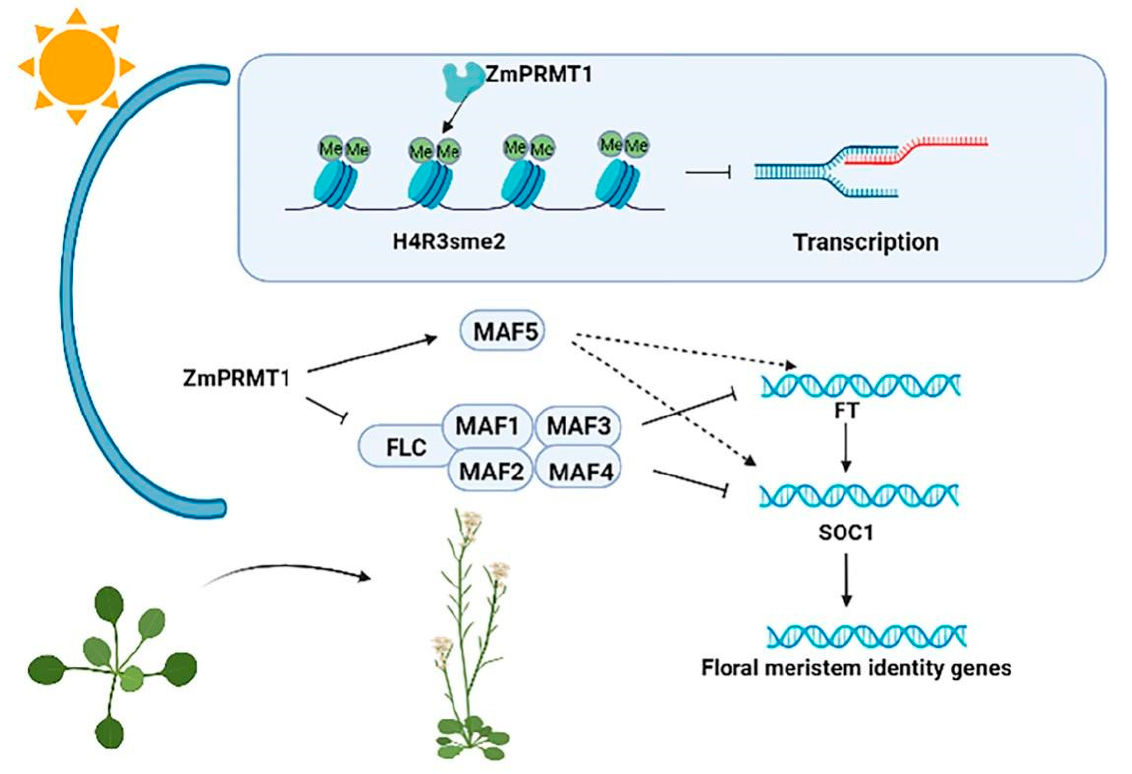
Figure 12. Hypothetical model for the regulation of flowering time controlled by ZmPRMT1 in Arabidopsis . Overexpression of ZmPRMT1 in Arabidopsis leads to downregulation of the expression levels of FLC and MAF genes ( MAF1-MAF4 ), and its products assembled into MADS-box repressor complexes. However, the expression levels of MAF5 were upregulated with an unclear manner in plant growth process. FLC and MADS domain complex forms large protein complexes at the FT and SOC1 sites to repress the expression of these two genes. H4R3sme2 is one of the possible targets for ZmPRMT1 to function. The arrows indicate positive modulation, and the “T” bars indicate negative modulation. The dashed lines represent assumed